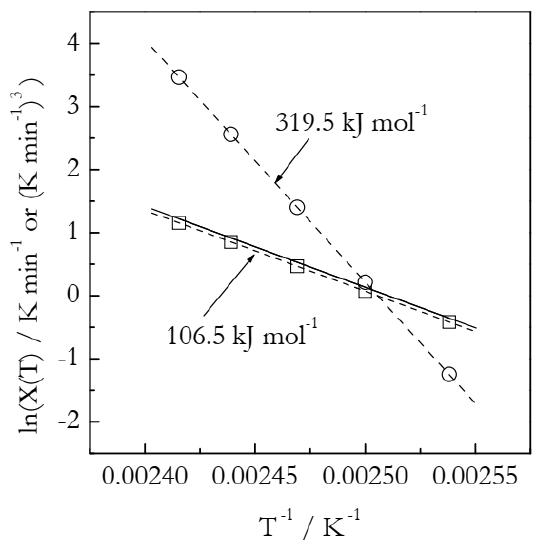
Figure 3. Arrhenius plots of the heating function. Circles and squares represent, respectively, ln χ ( T )